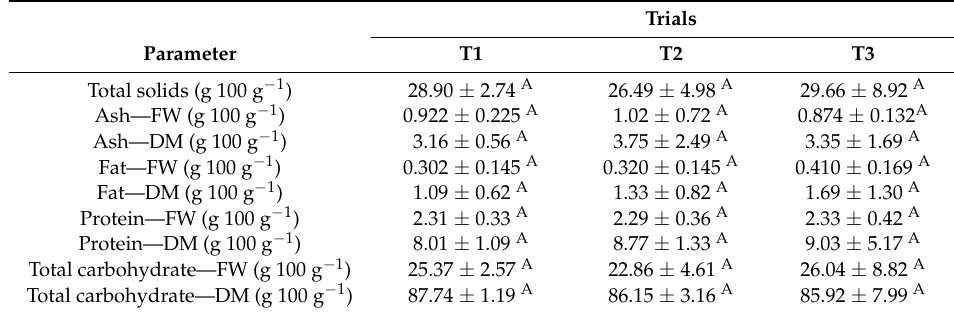
Table 2. Mean composition of fermented dairy dessert trials containing jabuticaba peel ingredients on the first day of refrigerated storage at 4 ± 1 ◦